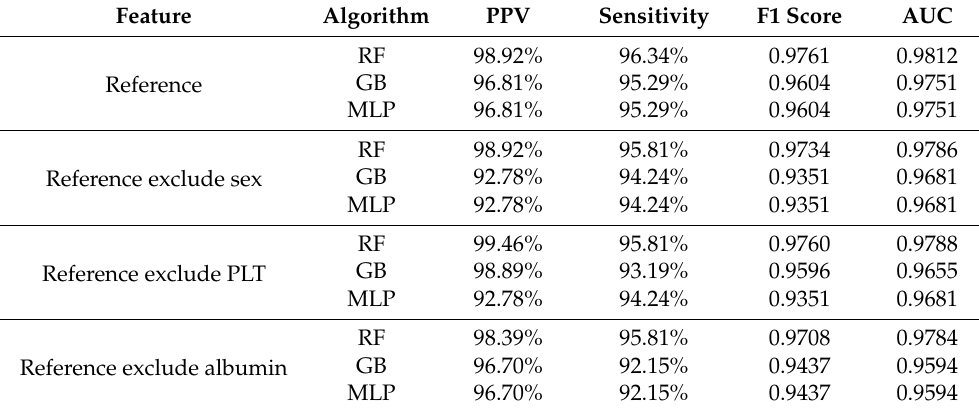
Table 4. Performance result of feature selection based on RF, GB, and